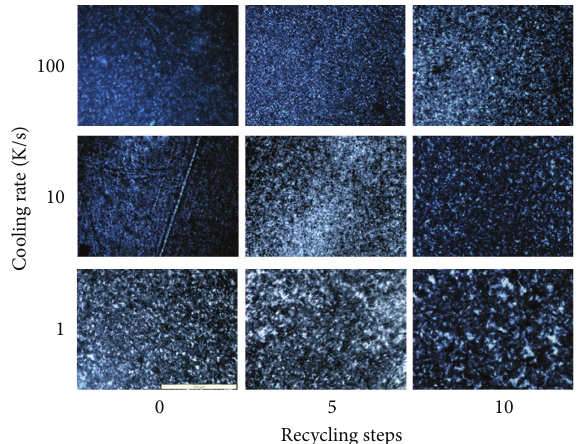
Figure 2: Optical images of the samples analyzed in this work: on the same row samples subjected to different recycling steps but solidified under cooling rates of the same order of magnitude are reported; on the same column samples having the same recycling history but solidified under different cooling rates are reported. All the images are on the same magnification scale; namely, the longest side is about 400 𝜇